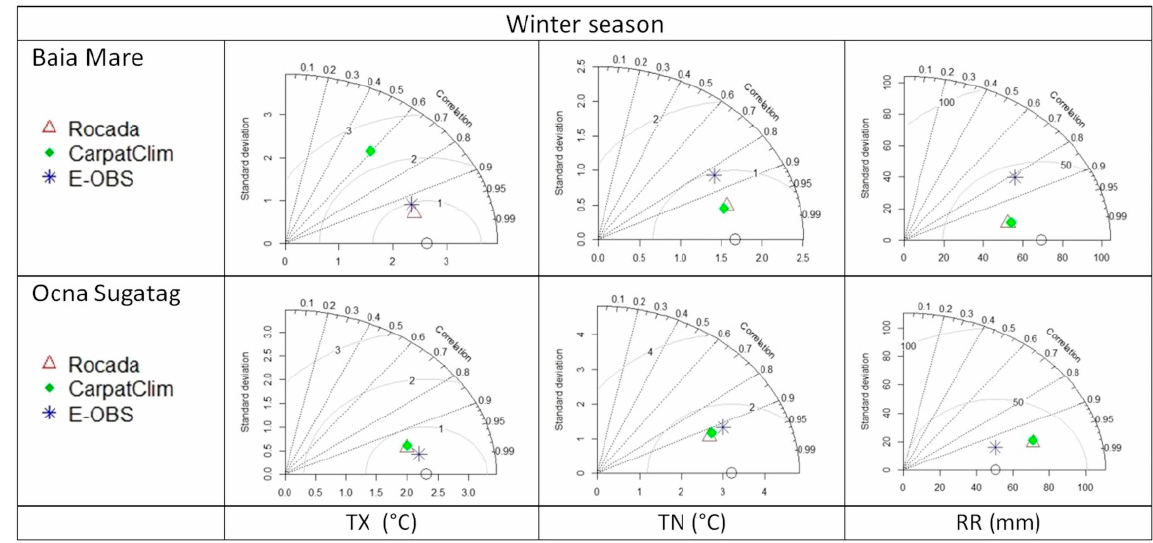
Figure 8. Taylor diagrams for winter (TX, TN, and RR) at the Baia Mare and Ocna Ș ugatag weather stations (1961–2010).